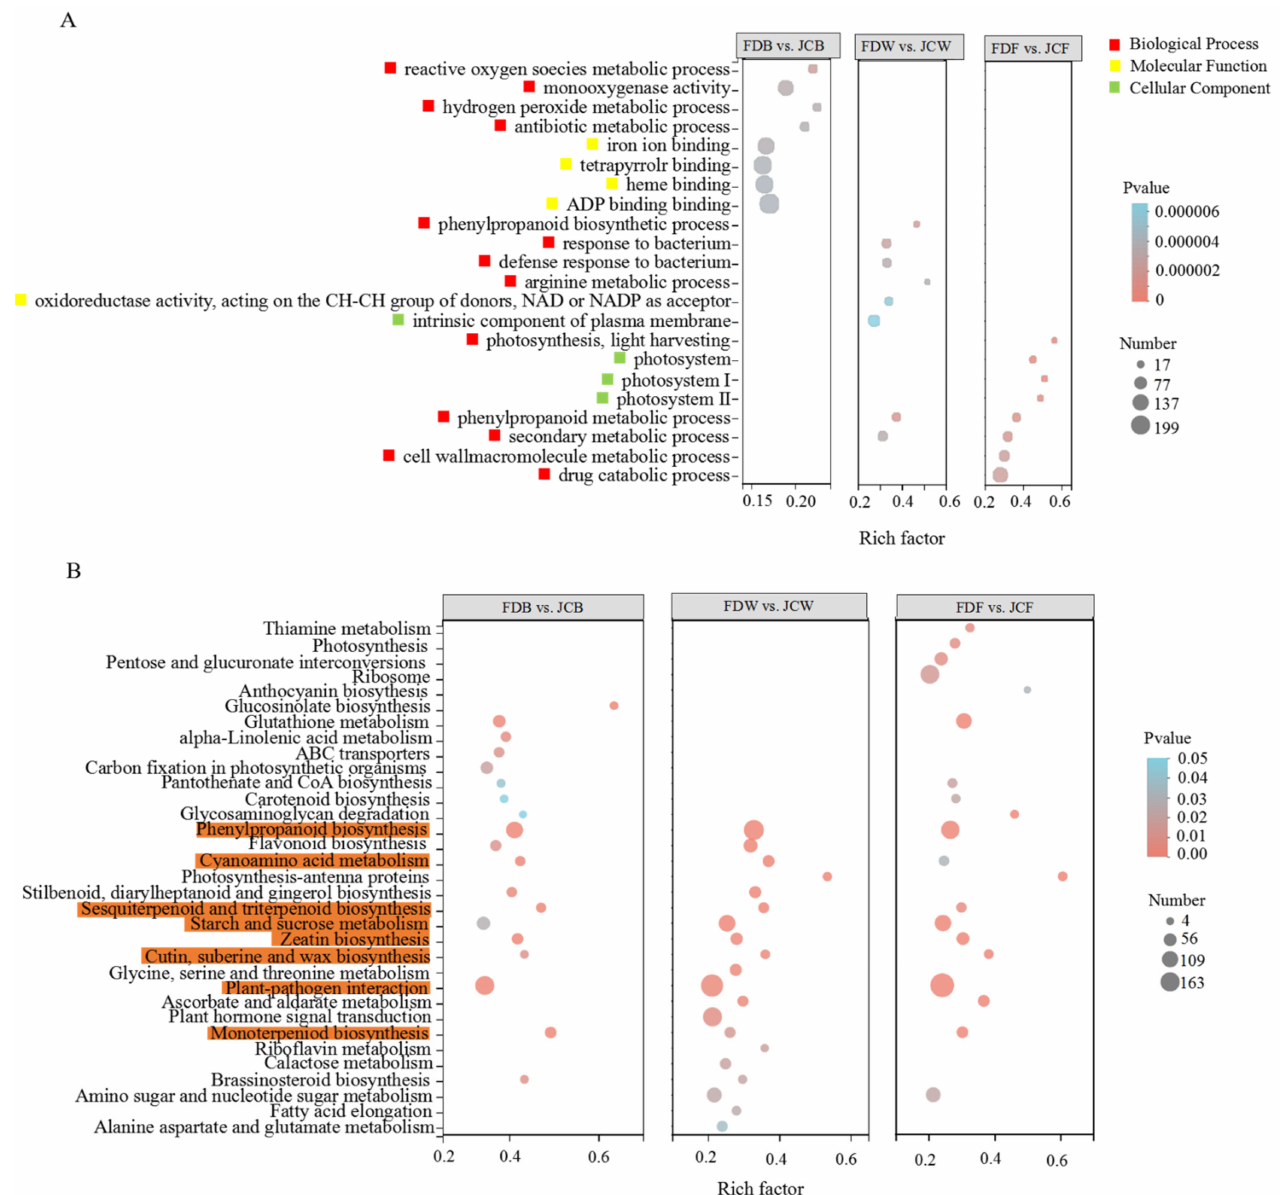
Figure 4. Go enrichment analysis of DEGs ( A ) and KEGG enrichment analysis of DEGs ( B ). Note: The metabolic pathways shown in red are common to all three